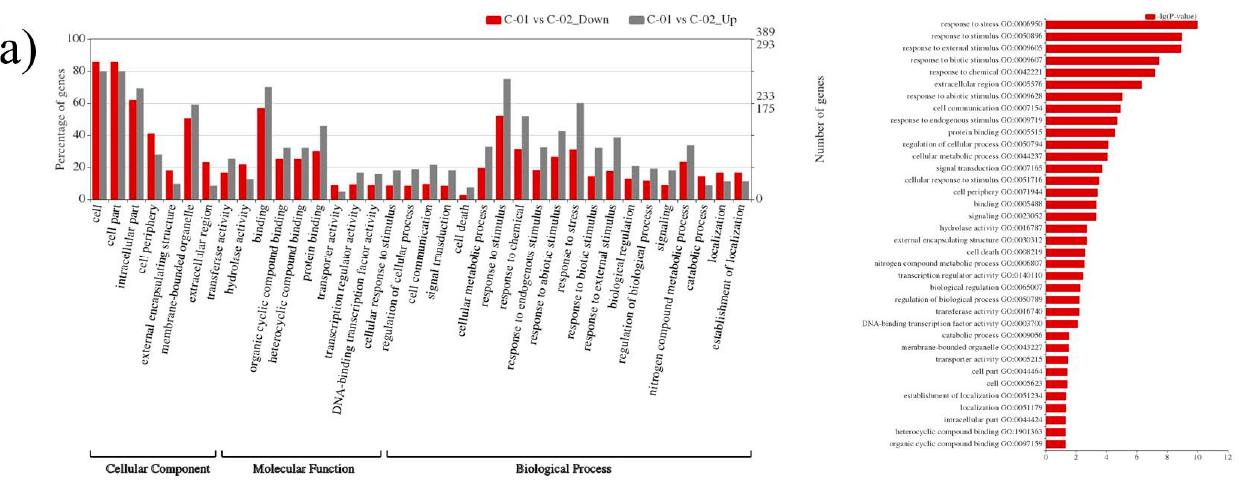
Figure 5. Heat map showing the gene expression pattern of common DEGs in ( a ) Clivus and ( b ) I-476. Corresponding log2 fold change is displayed inside the box. Each species was treated with three different concentrations of CO 2 . C-400, Clivus CO 2 400 ppm; C-560, Clivus CO 2 560 ppm; C-720, Clivus CO 2 720 ppm; I-400, I-476 CO 2 400 ppm; I-560, I-476 CO 2 560 ppm; I-720, I-476 CO 2 720 ppm.